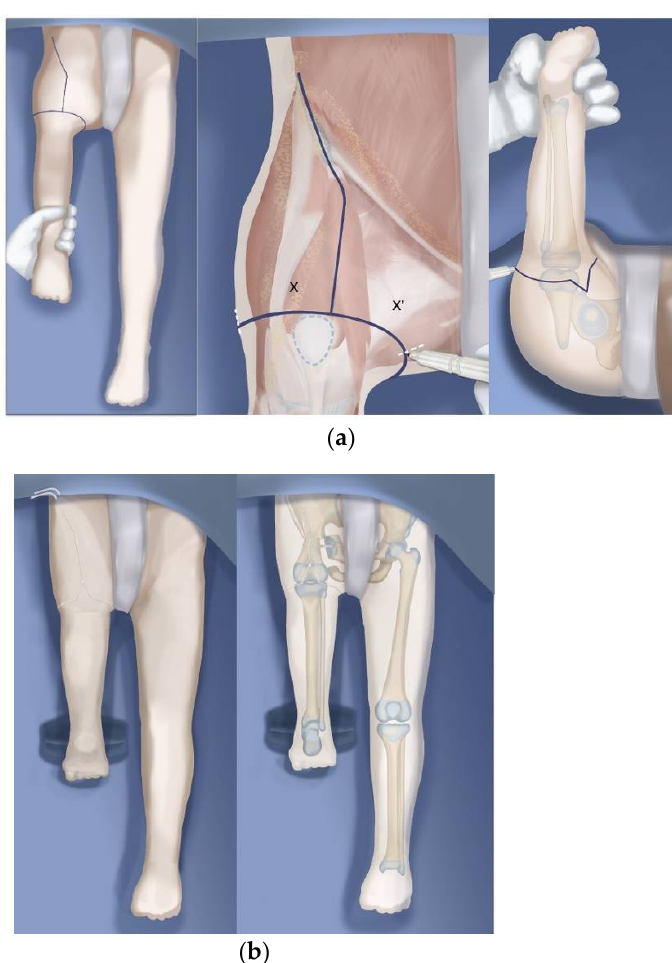
Figure 8. ( a ) Illustration of the new Pinsky incision line for Brown, Paley–Brown and Paley type rotationplasties. The 3cm equilateral triangle on the posteromedial side is located at 5 o’clock for right legs and 7 o’clock for left legs. ( b ) After closure of the Pinsky incision with the triangle inserted anteriorly between the flaps. The wound edges except the triangle are all resected back one cm or more before closure.